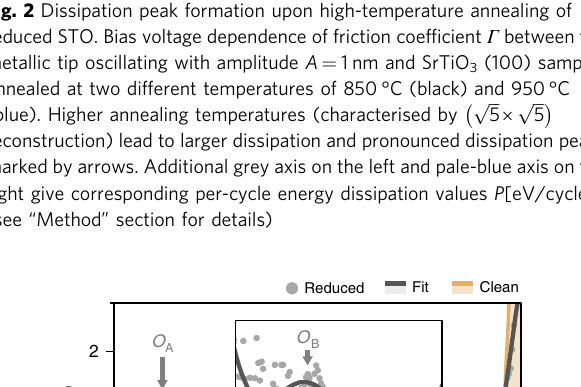
ffiffiffi p ffiffiffi p (cid:3) (cid:4) ´ reconstructed STO 5